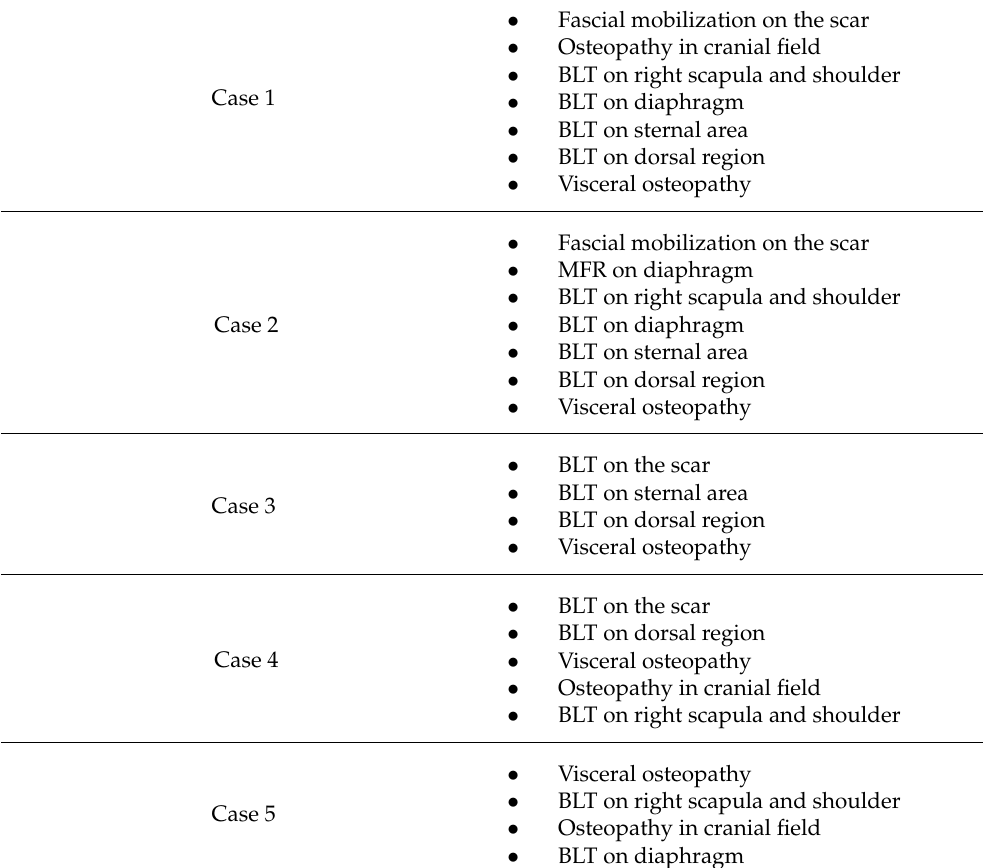
Figure 1. Timeline of osteopathic evaluations and treatments. Numbers indicate the session and arrows show the time between sessions in weeks. OMT = osteopathic manipulative treatment. Technique Table 2. Techniques per each case during all OMT In Table 2, the techniques per each case during all OMT sessions are reported.